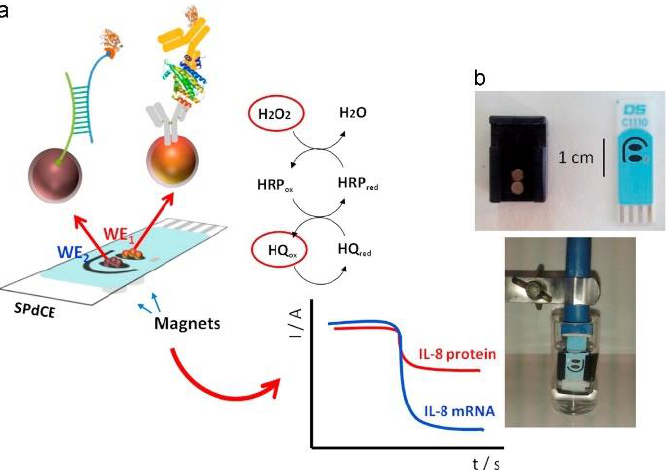
Figure 17. ( a ) Schematic illustration of a magnetoimmunosensor for the simultaneous determination of IL-8 mRNA and IL-8. ( b ) Photograph of the SPdCE and the magnet holding block (top), and the modified Mbs on the SPdCE assembled on the magnet holding block dipped in a solution (bottom). Reprinted from [156] with permission from Elsevier.